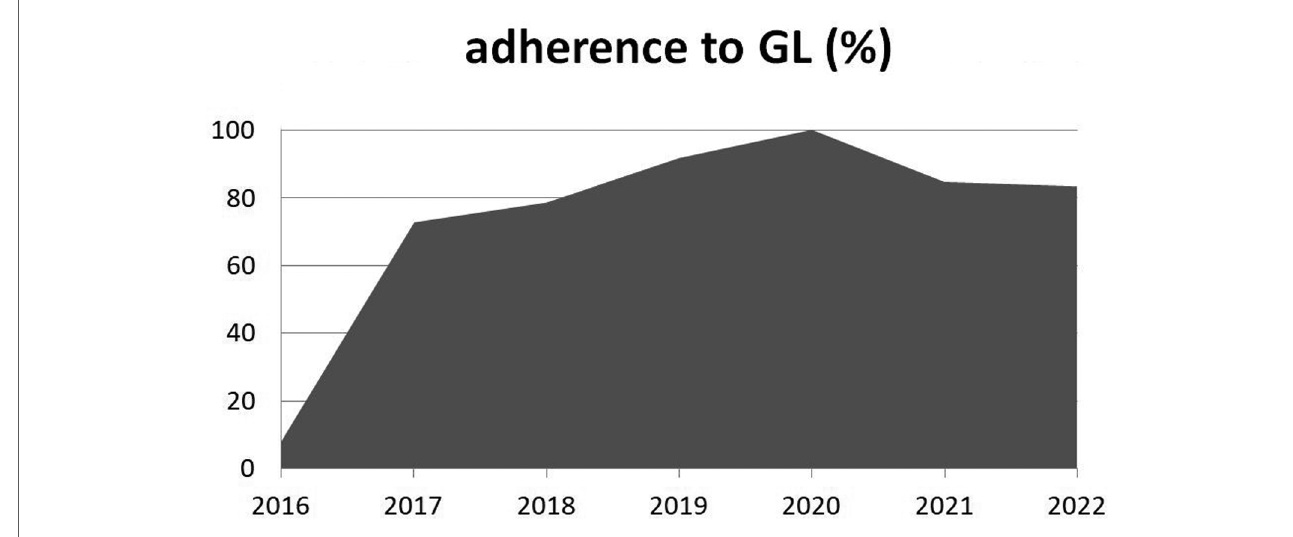
FIGURE 2 Adherence to the guidelines (GL, %) over the post-intervention years. Legend: GL,